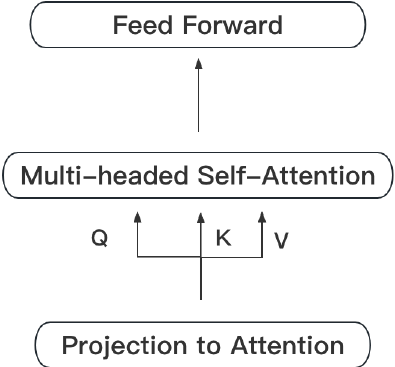
Figure 3. The structure of an internal self-attention